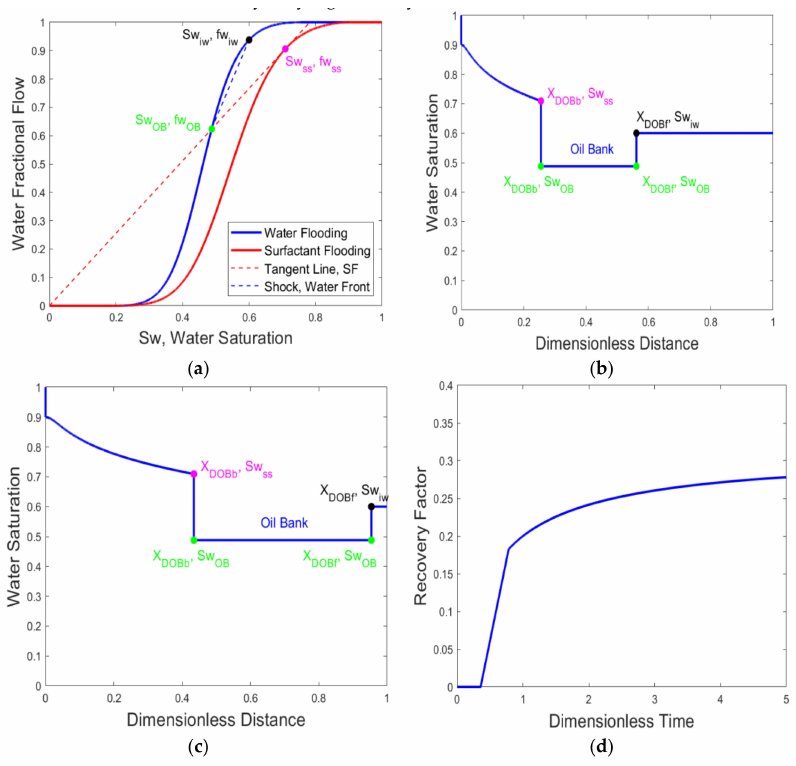
Figure 8. ( a ) Construction of shock front; ( b ) water saturation profile at t D = 0.20 PV; ( c ) water saturation profile at t D = 0.34 PV; and ( d ) cumulative oil recovery during tertiary continuous surfactant flooding, no adsorption, no